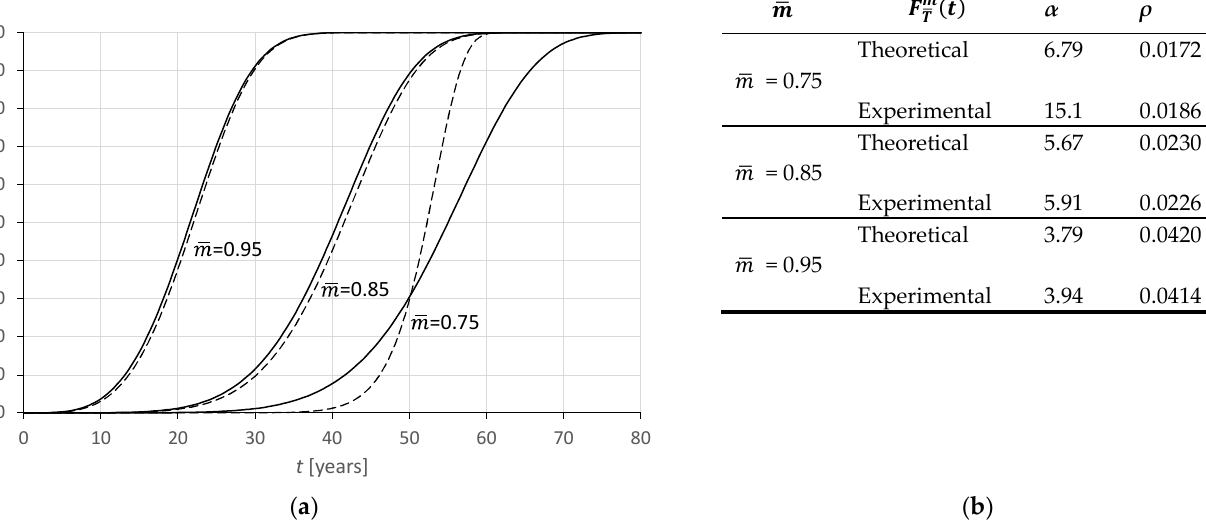
Figure 7. Scenario 1: ( a ) Comparison between experimental curves obtained for scenario 1 and the fragility curves defined as “statistical truth”. ( b ) Parameters of the theoretical and experimental distributions compared.